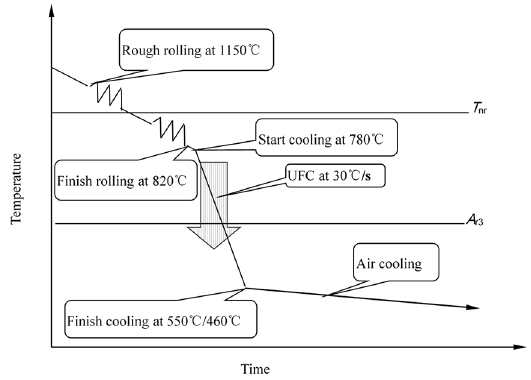
Figure 2. The processing schedule of the experimental and A r . 3 1